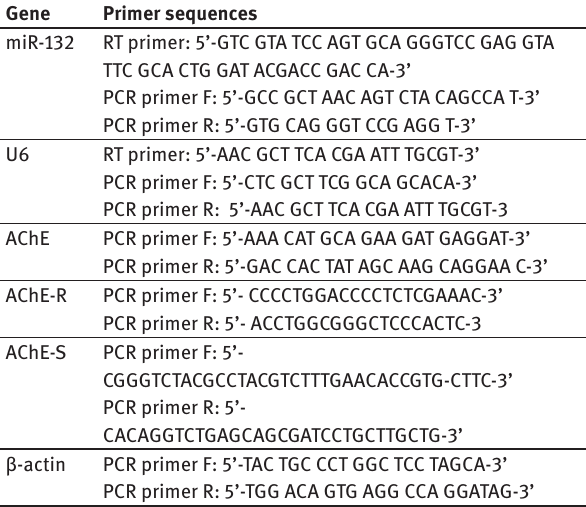
Table 1: Sequences of primers for reverse transcription and real-time quantitative.